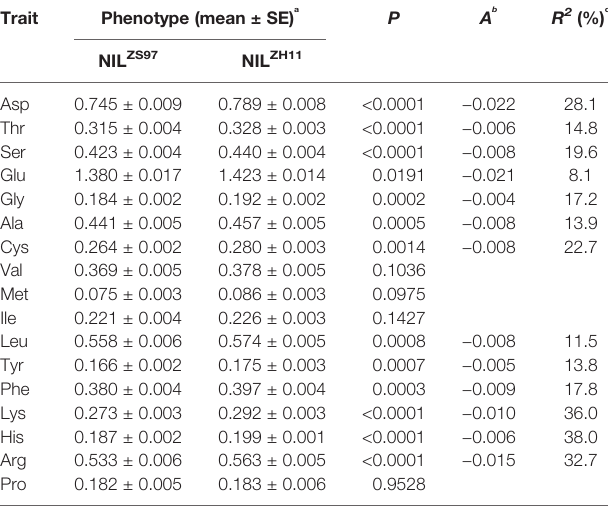
TABLE 3 | Effects of the RFT1 - Hd3a region on 17 components of amino acid content (AAC) detected in the TF6-15 population. Trait Phenotype (mean±SE) a